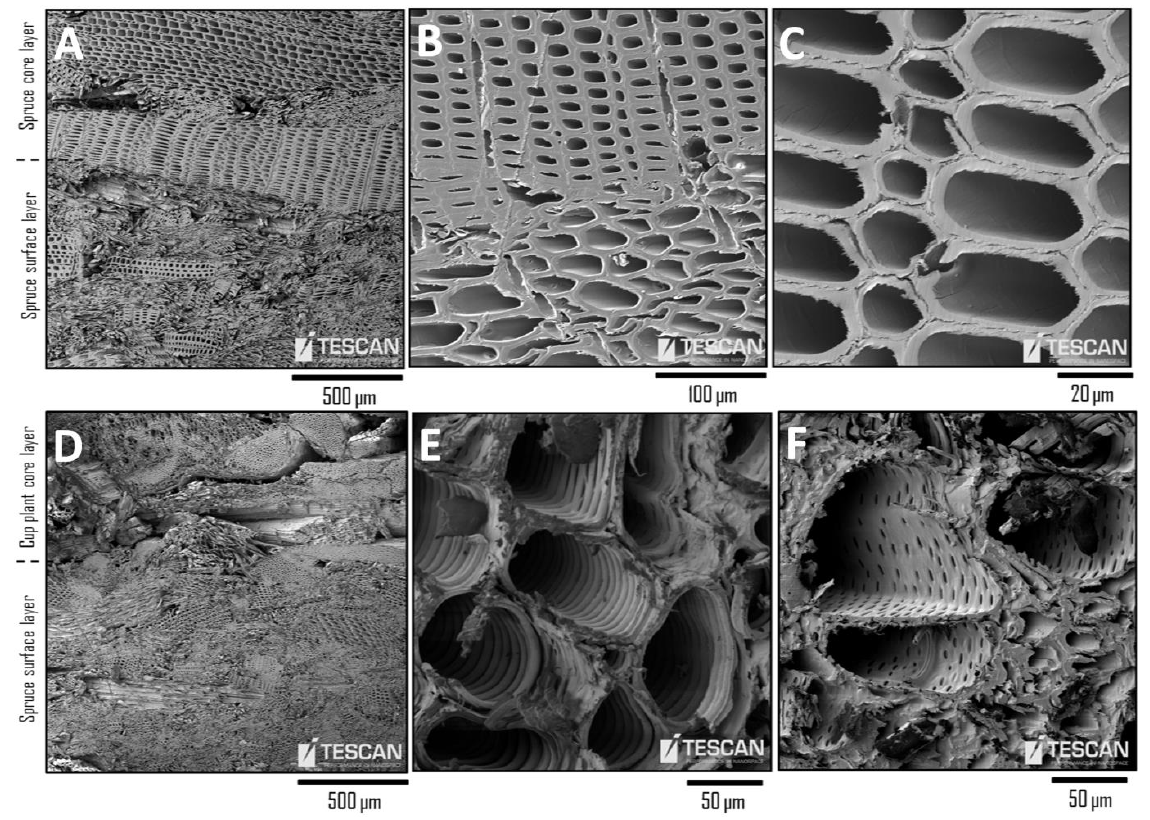
Figure 3. Cross-sectional SEM images of the spruce ( A – C ) and cup-plant core layer—spruce surface layer ( D – F ) PBs.